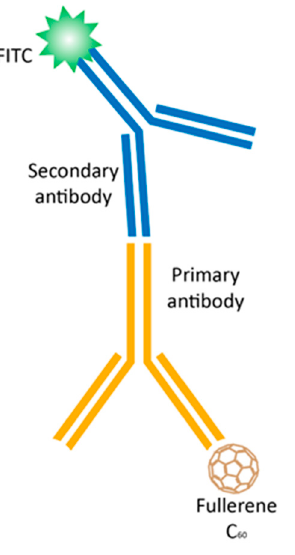
Figure 8. Immunofluorescence staining to assess the intracellular accumulation of C 60 : a primary monoclonal antibody IgG against C 60 binds to C 60 ; a FITC-labeled secondary antibody against the host species of the primary antibody binds to the primary antibody to allow detection with a fluo- rescence